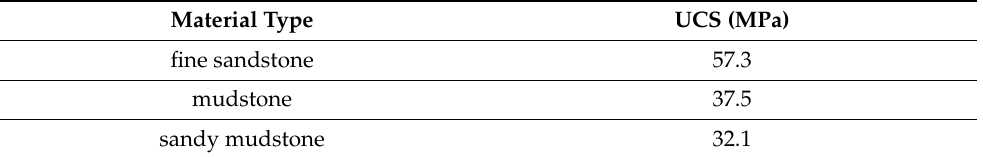
Table 1. The roof rock parameters of coal mine roadway.